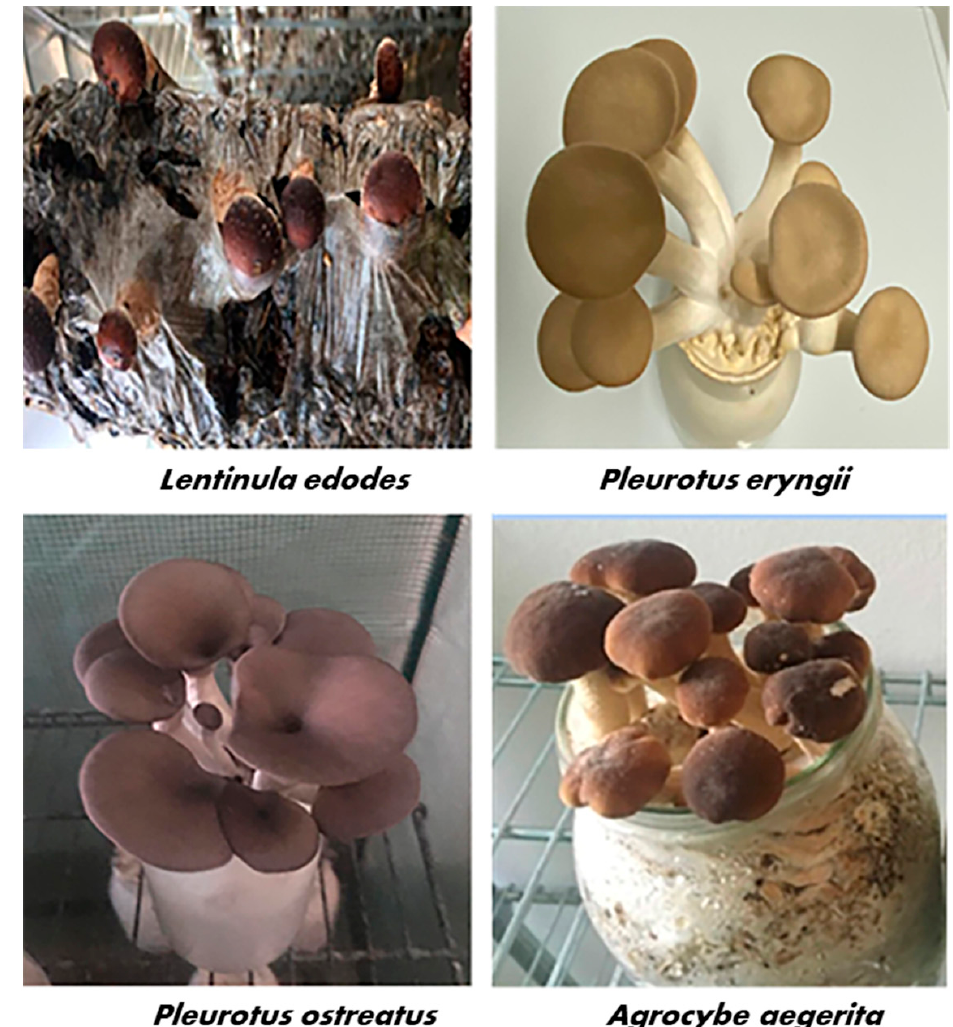
Figure 1. Fruiting bodies of Lentinula edodes , Pleurotus ostreatus , Pleurotus eryngii and Agrocybe aegerita cultivated under controlled conditions in the Bioagritest mycological research center (Interregional Center for Plant Diagnosis, Pignola, Italy) and used for the preparation of crude